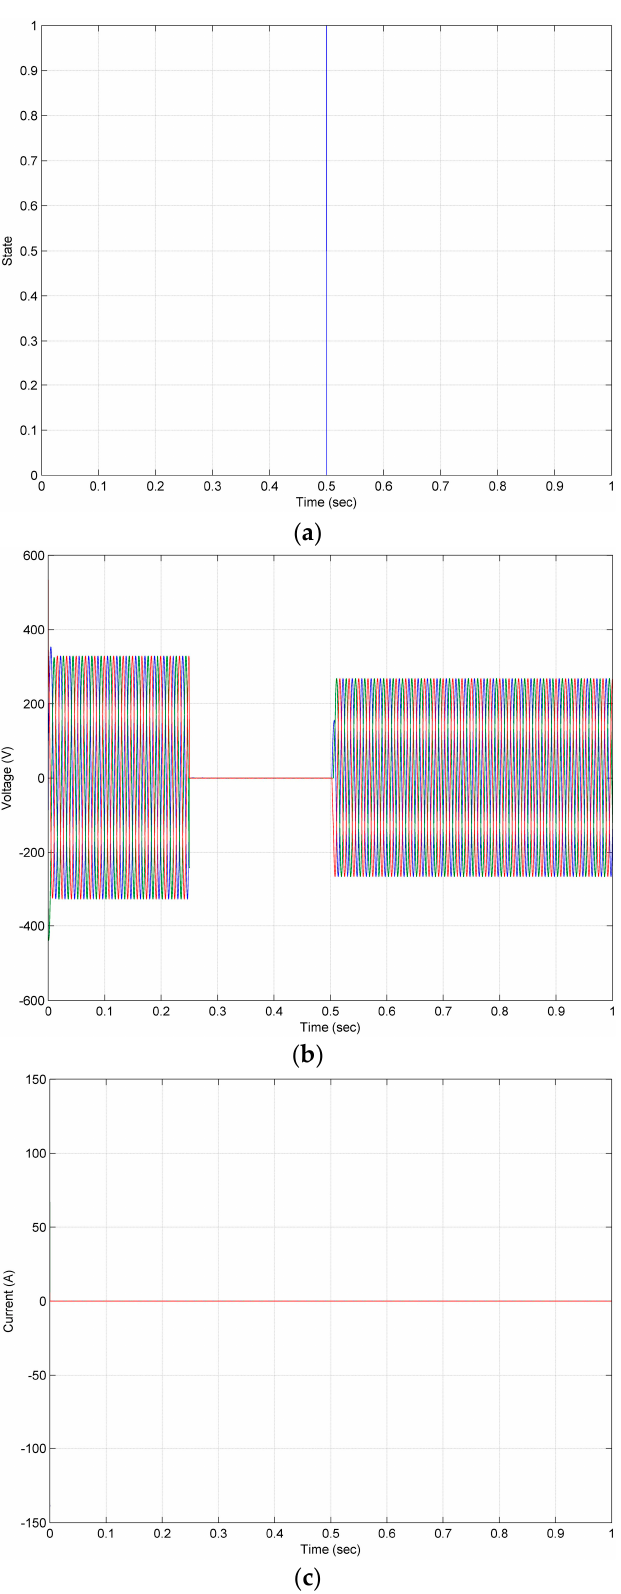
Figure 14. ( a ) CB11 CLOSE/TRIP state; ( b ) Feeder voltage waveforms of CB11 under islanded mode and fault occurrence at Bus 2; ( c ) Feeder current waveforms of CB11 under islanded mode and fault occurrence at Bus 2.